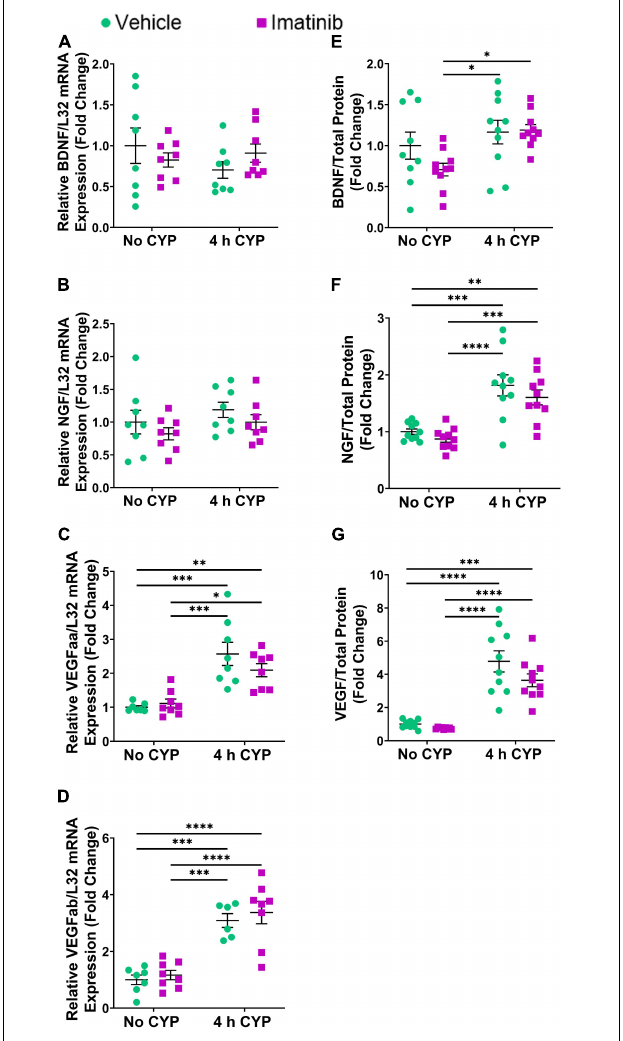
FIGURE 5 | Transurethral bladder infusion of imatinib mesylate does not significantly affect VEGF, BDNF or NGF mRNA transcript (lamina propria, LP) or protein (whole urinary bladder) expression in an acute (4 h) cyclophosphamide (CYP)-induced cystitis female mouse model. Acute (4 h) CYP treatment (200 mg/kg, i.p.) significantly ( p ≤ 0.001) increased (C) VEGFaa (2.6-fold) and (D) VEGFab (3.1-fold) mRNA but did not affect (A) BDNF or (B) NGF mRNA transcript expression in the bladder LP, in female mice that received vehicle (saline) intravesical infusion 4 h post CYP injection, compared to vehicle infused (no CYP) controls. 4 h CYP treatment significantly (0.0001 ≤ p ≤ 0.001) increased (F) NGF (1.8-fold) and (G) VEGF (4.8-fold) but did not affect (E) BDNF whole bladder protein expression, compared to vehicle controls. Imatinib treatment via transurethral intravesical infusion (50 µ M, 30 min) 4 h post CYP administration, did not significantly affect (A) BDNF, (B) NGF, (C) VEGFaa, or (D) VEGFab mRNA transcript expression in the bladder LP, nor (E) BDNF, (F) NGF, or (G) VEGF protein expression in whole bladder samples in female mice with 4 h CYP-induced cystitis. mRNA transcript and protein expression were measured by real time qRT-PCR and ELISAs, respectively. mRNA transcript expression was normalized to expression of the house keeping gene, L32. Raw mRNA transcript and ELISA values (pg/mL) are presented as fold change values ± SEM with respect to the control group (vehicle, no CYP). n = 6–10. * p ≤ 0.05; ** p ≤ 0.01; *** p ≤ 0.001; **** p ≤ 0.0001 by two-way ANOVA with Tukey’s multiple comparisons